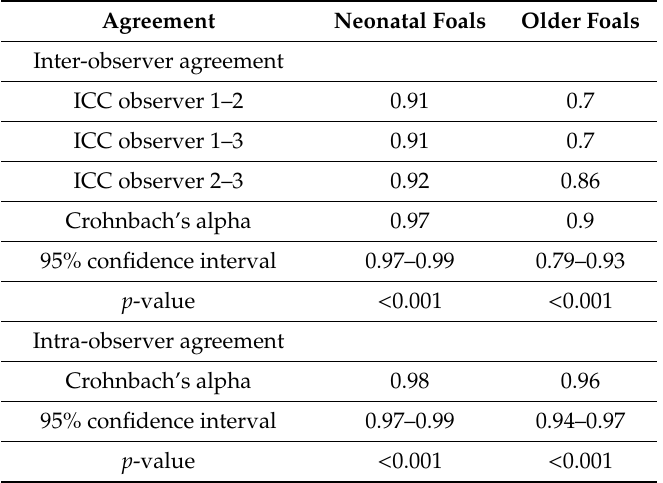
Table 3. Inter- and intra-observer agreement of total pain scores of EQUUS-FAP FOAL (Equine Utrecht University Scale for Facial Pain Assessment for foals).